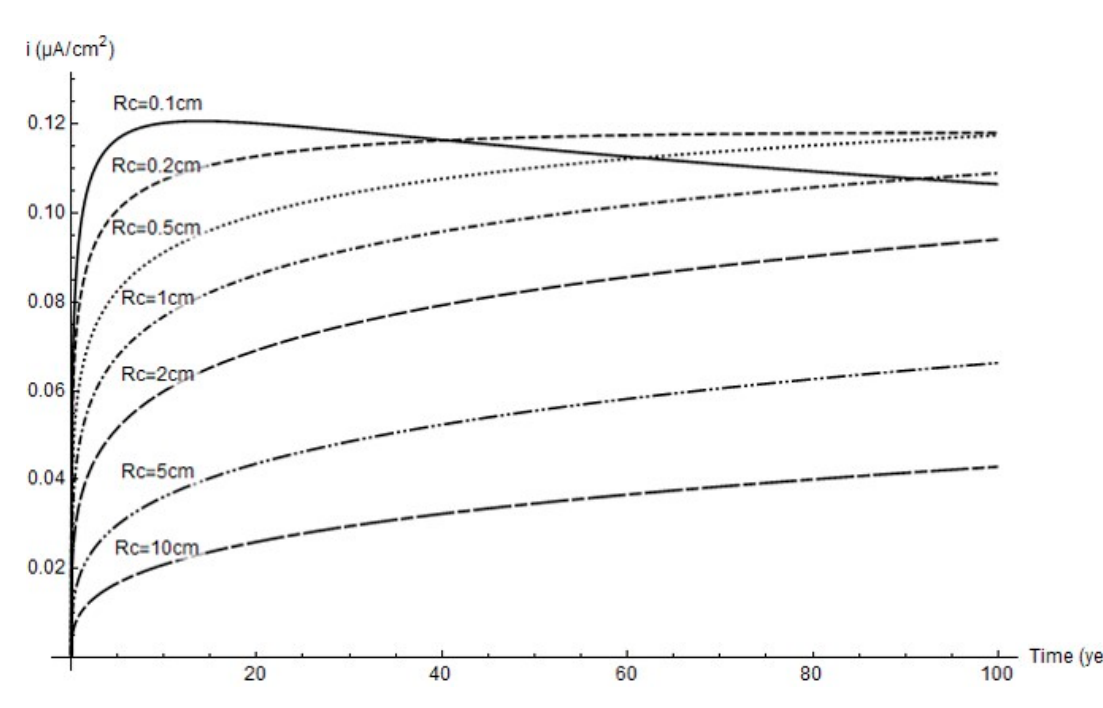
Figure 9. Variation in corrosion rate over time at different cathode radii.